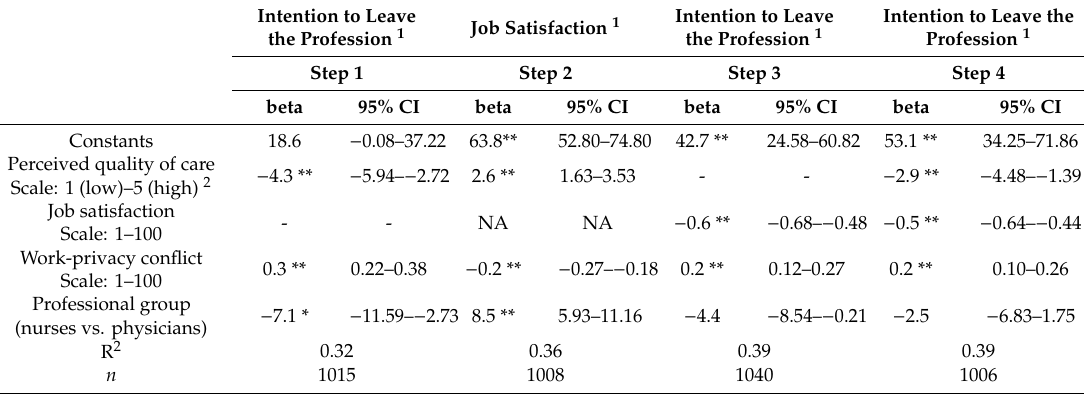
Table 2. Regression models of the mediation analysis according to Byron and